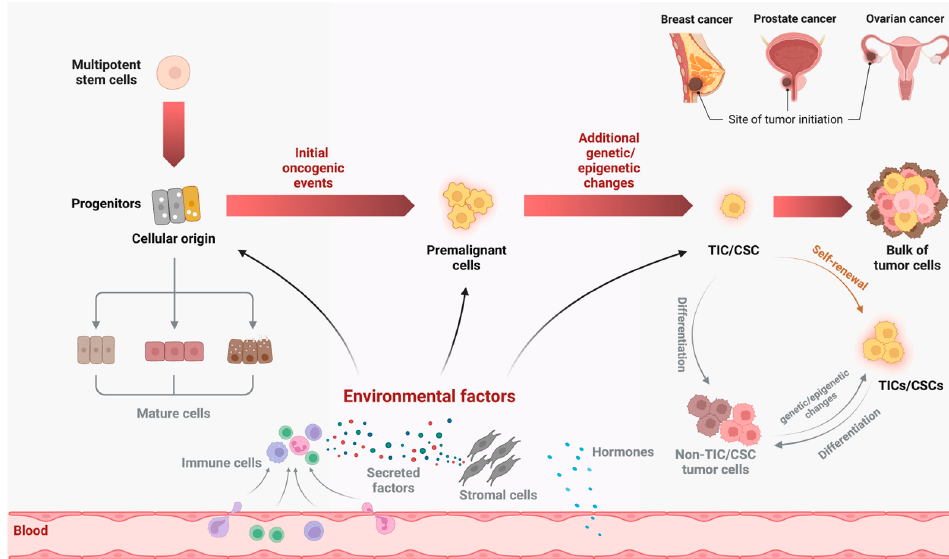
Figure 1. Schematic diagram depicting the developmental link between tumor-initiating cells (TICs)/cancer stem cells (CSCs) and their cellular origins (normal cells). In breast, prostate, and ovarian cancers, luminal progenitors in their corresponding tissues/organs (in the case of ovarian cancer, fallopian tube (FT)) are the preferred cellular origins.